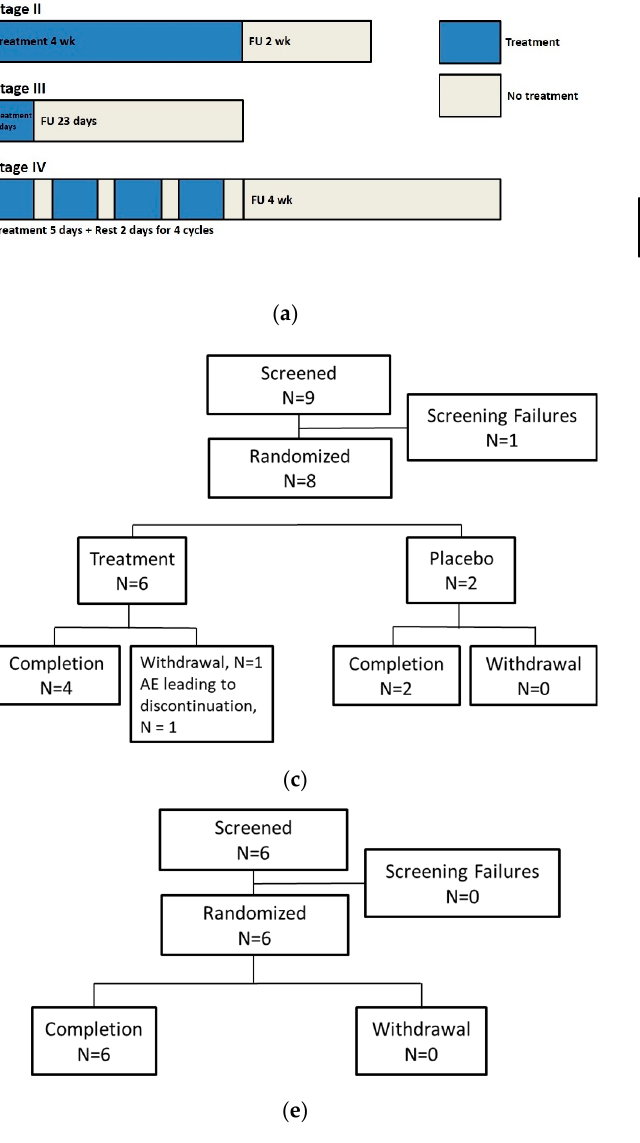
Figure 1. The study design and flow chart of the patient enrollment. ( a ) The study design. ( b ) Stage I: KX01 0.01% or placebo administered topically twice daily for two weeks, followed by one week of wash-out, then twice daily for two weeks. ( c ) Stage II: KX01 0.1% or placebo administered topically twice daily for four weeks. ( d ) Stage III: KX01 1% administered topically once daily over five consecutive days. ( e ) Stage IV, KX01 1% administered topically over four cycles of five-day treatments followed by two days of rest